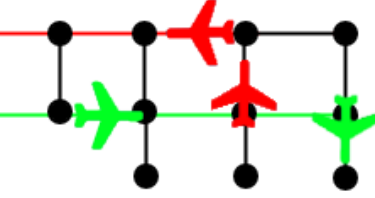
Figure 1. Merging point highways example. Red highways and red aircraft form one flow. Green highways and green aircraft form another flow.